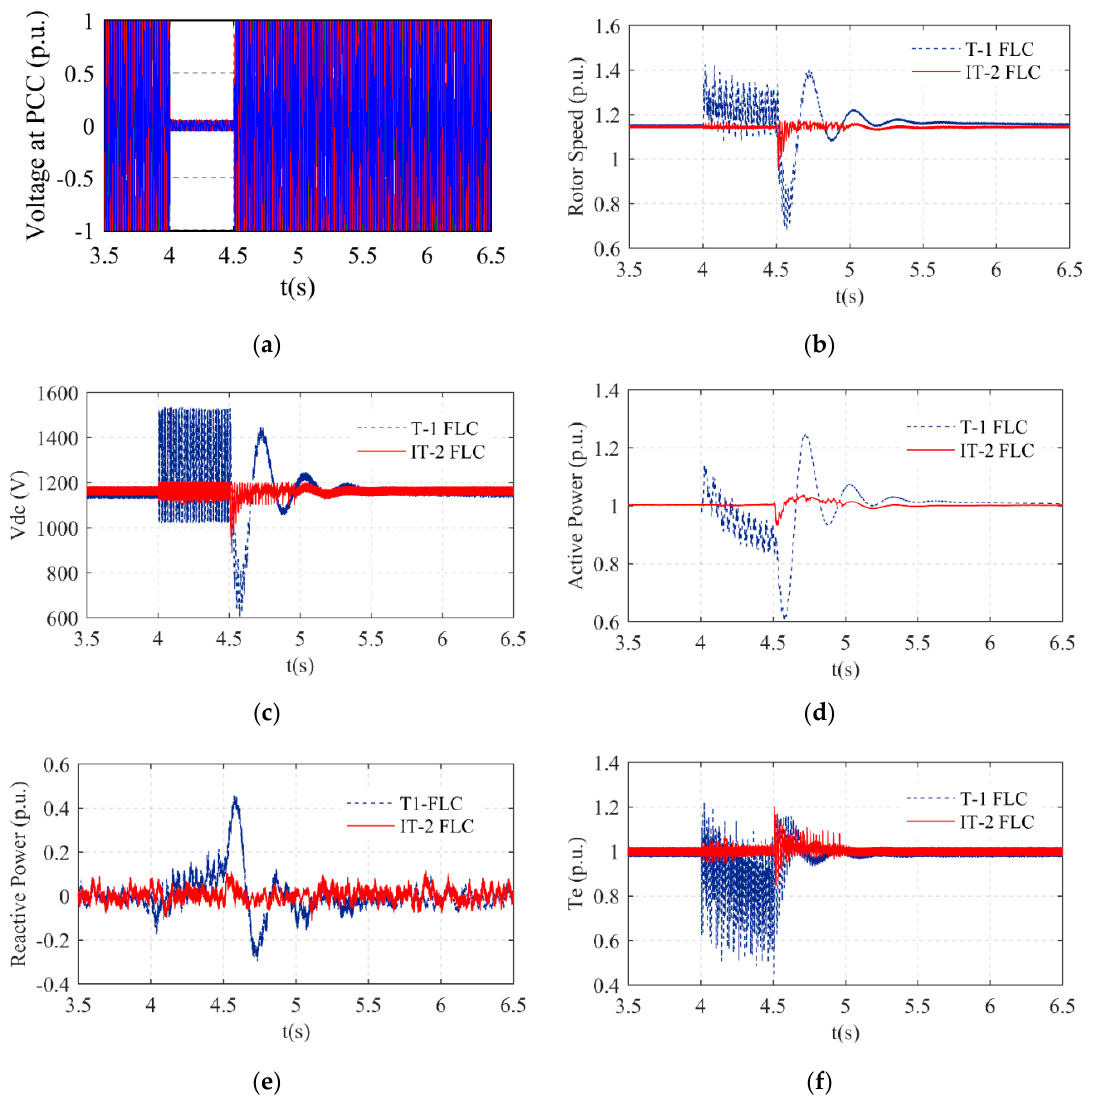
Figure 5. ( a – f ) . Dynamic response of a 1.5 MVA permanent magnet synchronous generator (PMSG) with the type-1 fuzzy logic control (T-1 FLC) and interval type-2 fuzzy logic control (IT-2 FLC) systems during a 3 / φ symmetrical